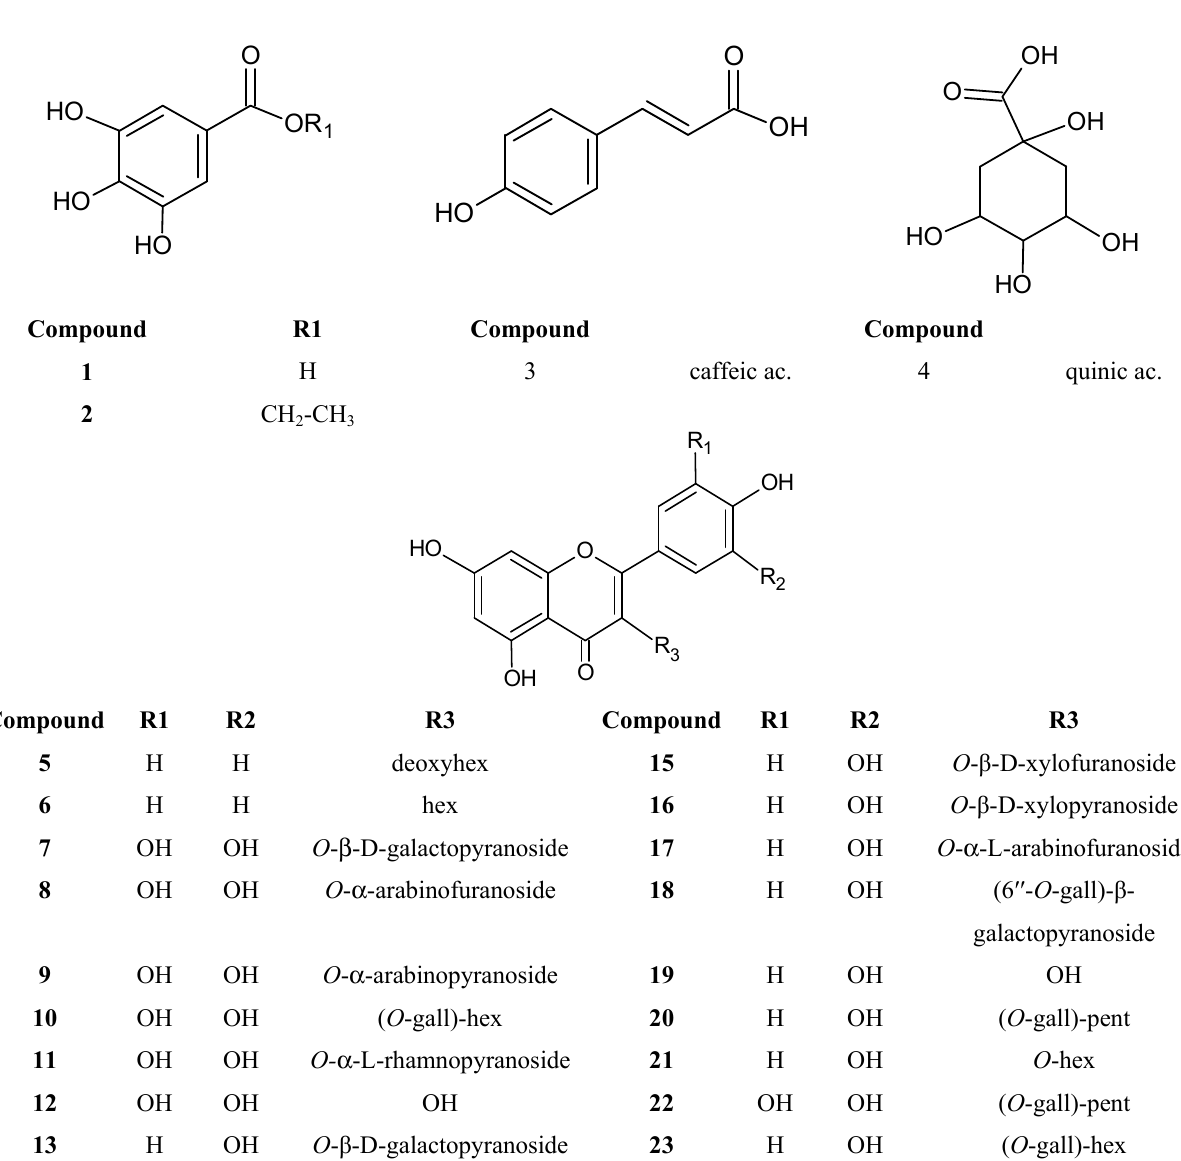
Figure 1. Structures of the constituents identified in the 70% EtOH leaves extract of M. bella